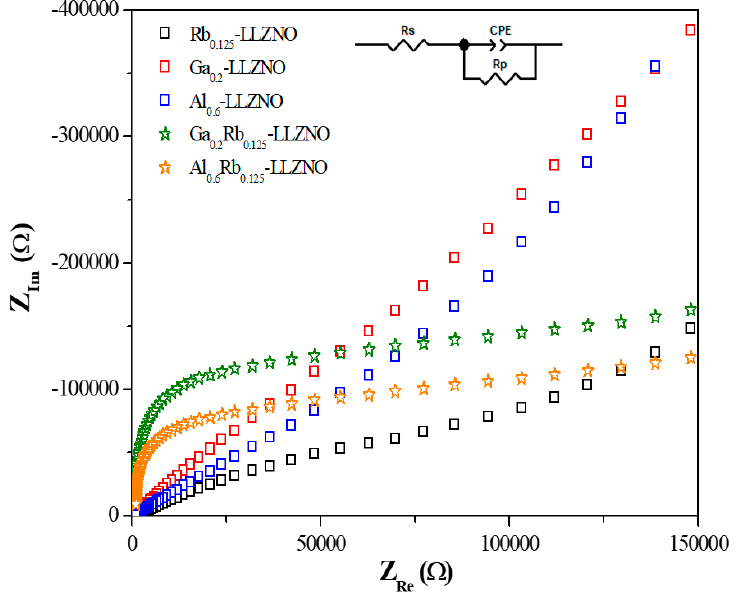
Figure 7. Nyquist plots of co- and tri-doped LLZO solid-state electrolyte ceramics ( Z Re and Z Im : real and imaginary part of impedance, respectively). Table 1. Li-ion conductivity of co- and tri-doped LLZO solid-state electrolyte ceramics.